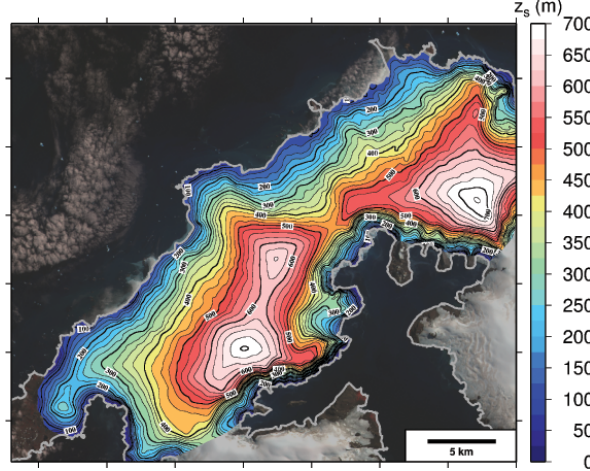
Figure 5. DEM of the interpolated ice surface topography z s in m (WGS84 ellipsoidal height) on King George Island (the con- tour line interval is 25m). The grey thick line shows the coastline. Database: compilation of the ground based survey (taken from Blin- dow et al., 2010) and the airborne measurements. Background im- age is a © SPOT Image from 2000.